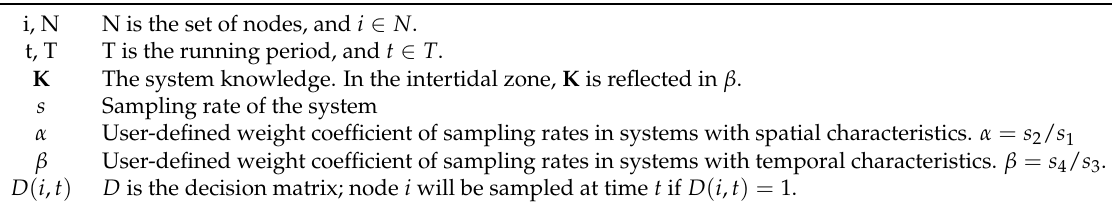
Table 3. Parameter notations in LESS.